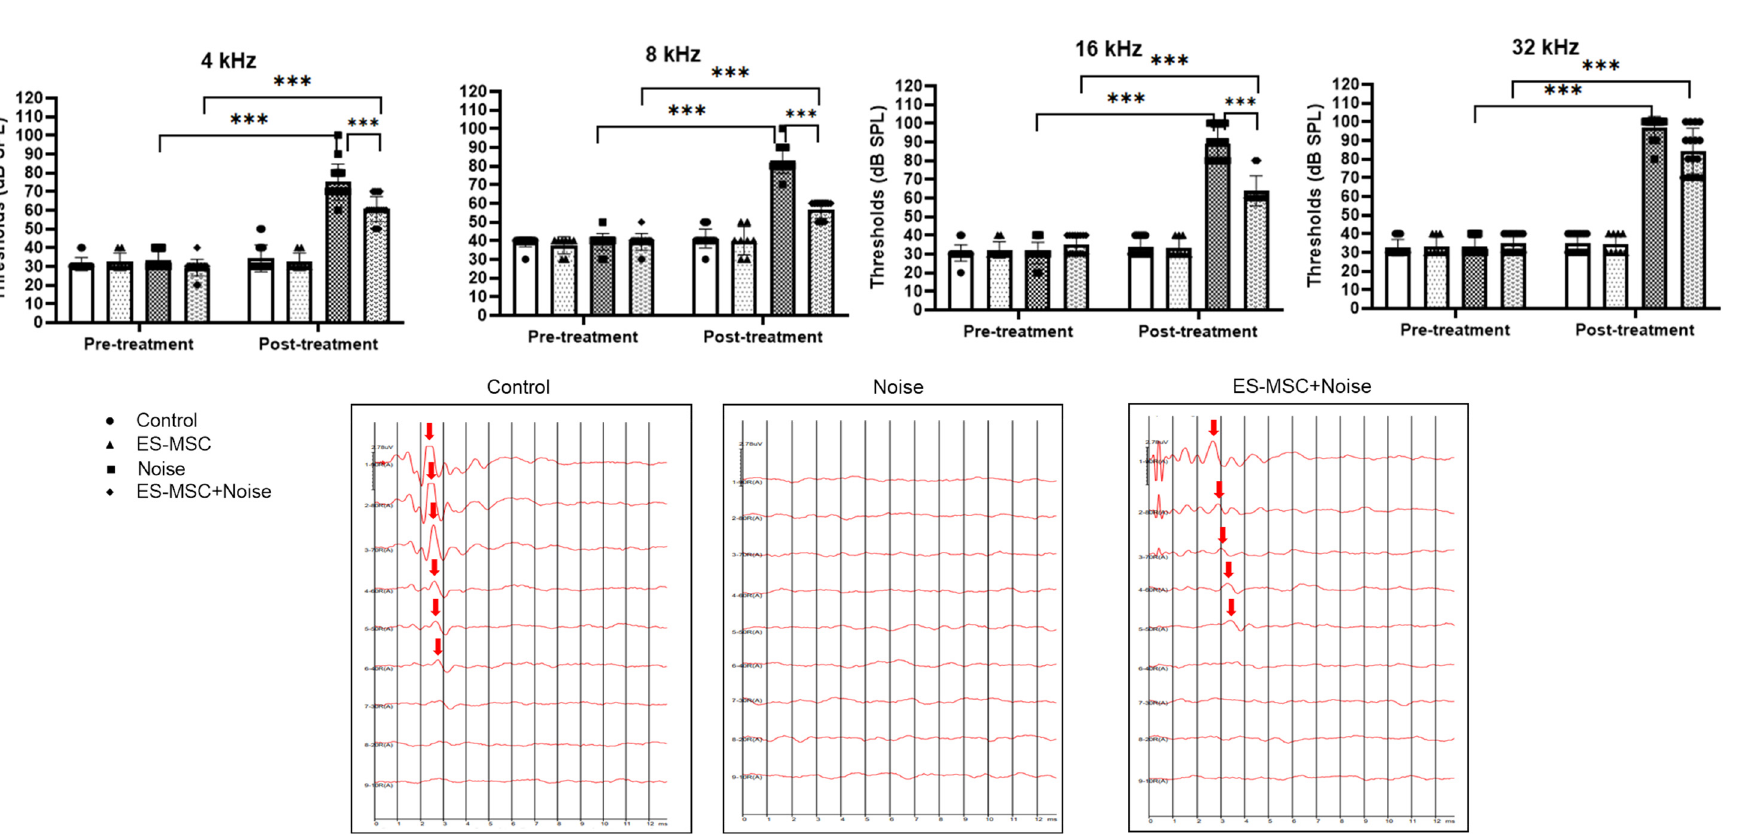
Figure 2. The ABR thresholds before (pretreatment) and after (posttreatment) ES-MSC and noise exposure ( n = 8 and 16 cochleae for control, noise, and ES-MSC+noise rats and n = 4 and 8 cochleae for ES-MSC rats). The ES-MSC + noise rats demonstrated lower ABR thresholds at 4, 8, 16 and 32 kHz. The ABR thresholds were increased after noise exposure. The ES-MSC pretreatment attenuated the ABR threshold shifts at 4, 8 and 16 kHz in the ES-MSC+noise rats. The representative images of ABR in the control, noise, and ES-MSC+noise groups. The red arrow indicated wave II of the evoked potential. (*** p < 0.001).